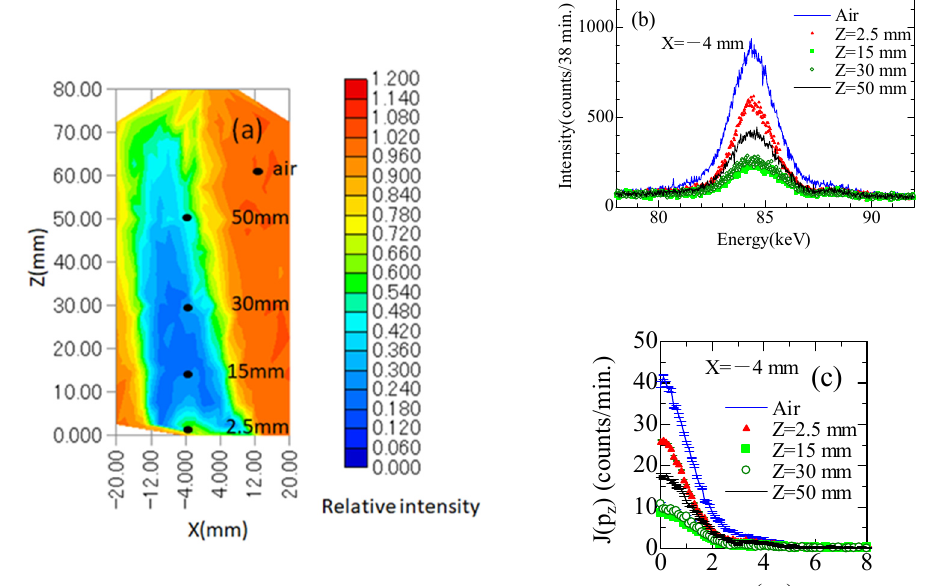
Figure 2. ( a ) Compton scattering X-ray intensity distribution of a laminar diffusion flame shown in Figure 1 b . The intensities are normalized those of air. ( b ) Compton scattered X-ray spectra at z = 2.5 mm, 15 mm, 30 mm, and 50 mm along x = − 4 mm and air shown in ( a ). ( c ) Compton profiles (electron momentum distributions) obtained from ( b ).